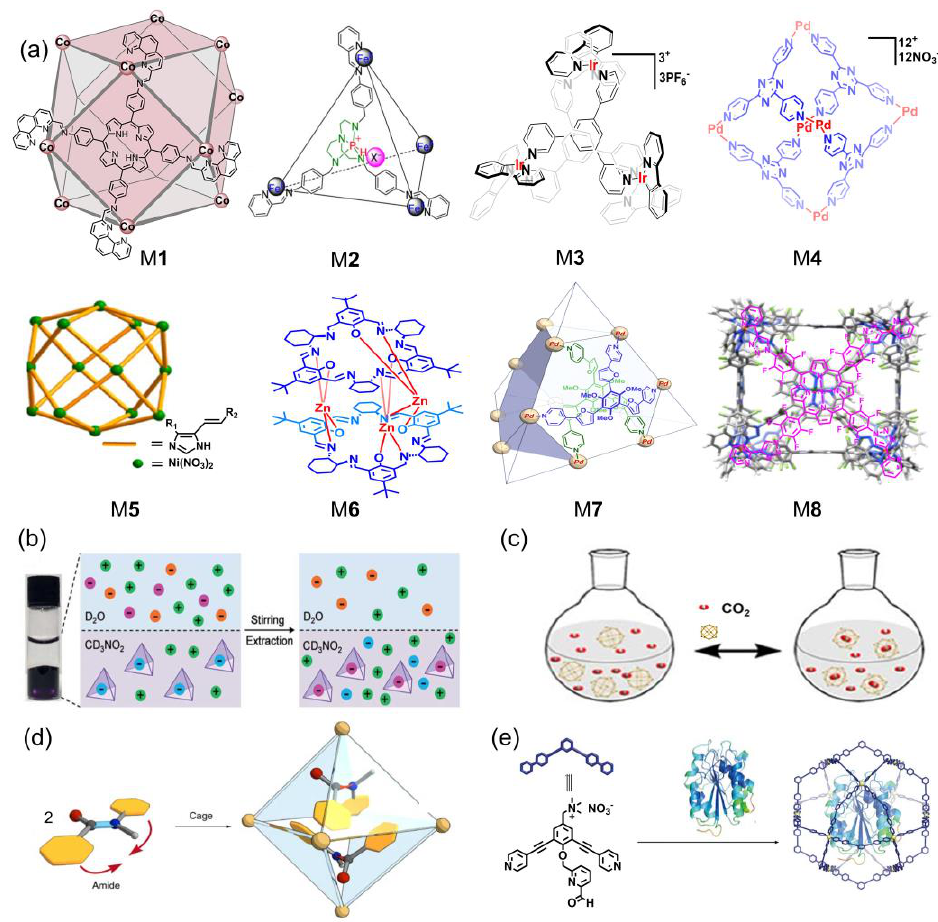
Figure 1. Encapsulation and separation of metallacycles and metallacages. ( a ) The structures of M 1 − M 8 . ( b ) Selective liquid-liquid extraction of ReO 4- from water into nitromethane in the existence of other anions. ( c ) Schematic of the encapsulation of CO 2 by M 5 in solution. ( d ) Schematic of the inclusion of diaryl amide within cage M 4 . ( e ) The encapsulation of a single-molecule protein.